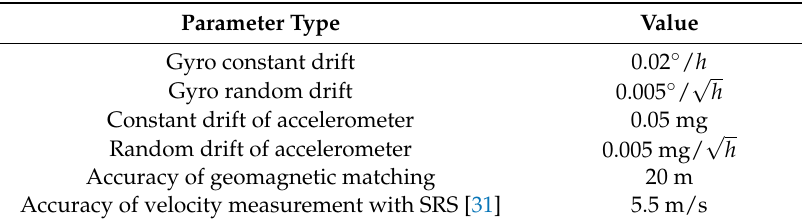
Table 1. Parameters of the sensors used in the simulation.